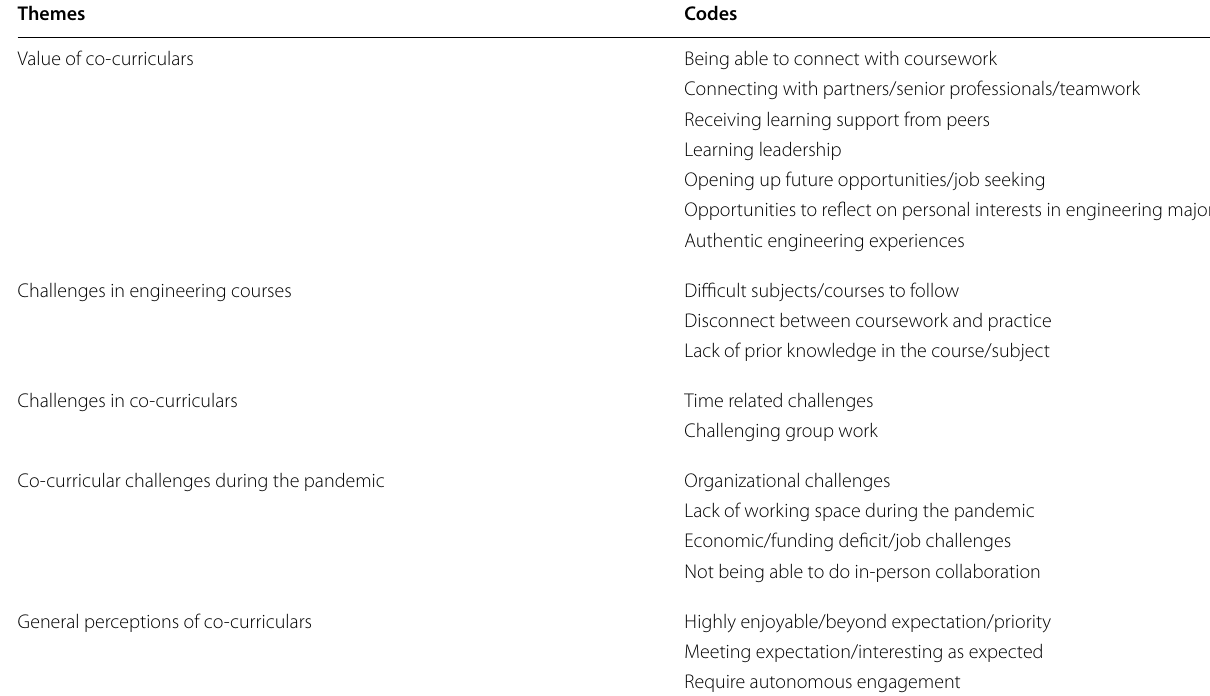
Table 4 Categories and themes from interview data analysis